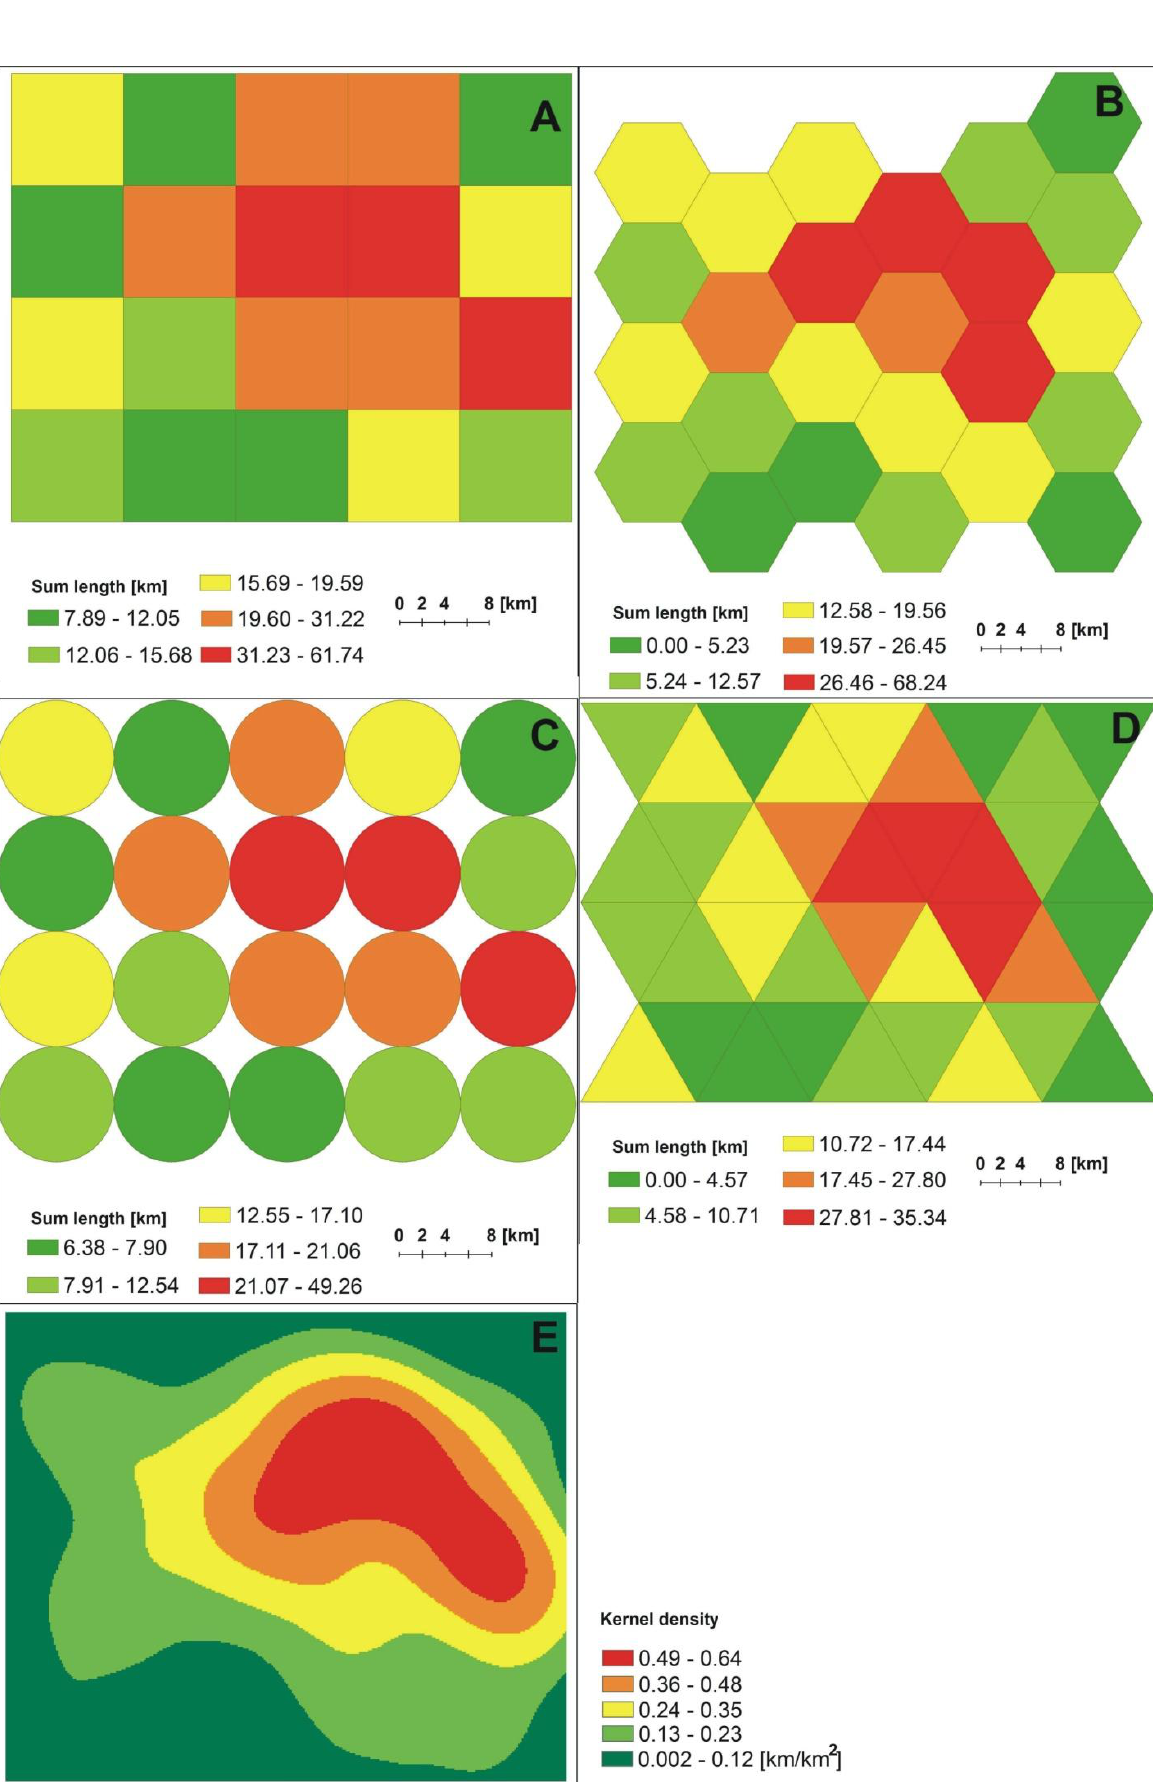
Fig. 11. Cartograms of line forms density in basic fields (10 km) A - squares, B - hexagons, C - circles, D - triangles and E - kernel